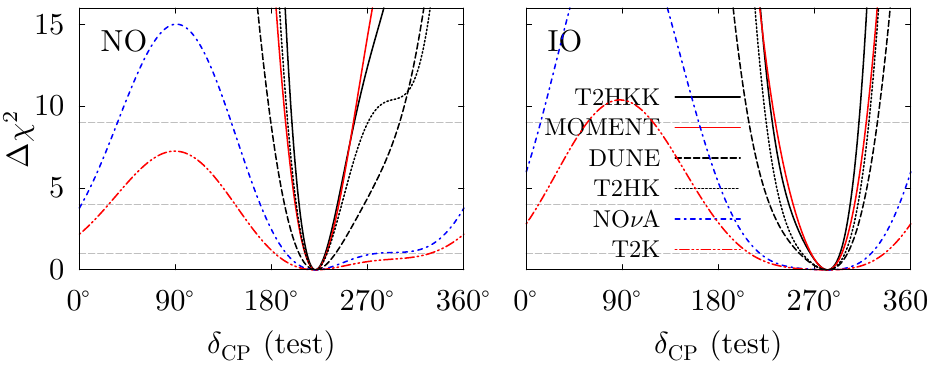
Figure 2. The sensitivity to the (cid:14) CP parameter in neutrino oscillation experiments. The (cid:1) (cid:31) 2 distributions of the (cid:14) CP parameter are shown for its allowed values (cid:14) CP = 0 (cid:14) . . . 360 (cid:14) . The 1 (cid:27) , 2 (cid:27) and 3 (cid:27) con(cid:12)dence levels are shown with the dashed lines corresponding to (cid:1) (cid:31) 2 = 1, 4 and 9, respectively. The sensitivities are shown for MOMENT, T2HK, DUNE, NO (cid:23) A and T2K, and for both normal (NO) and inverted mass orderings